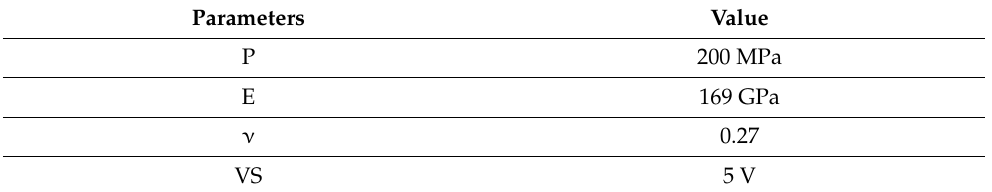
Table 4. Simulation parameters.